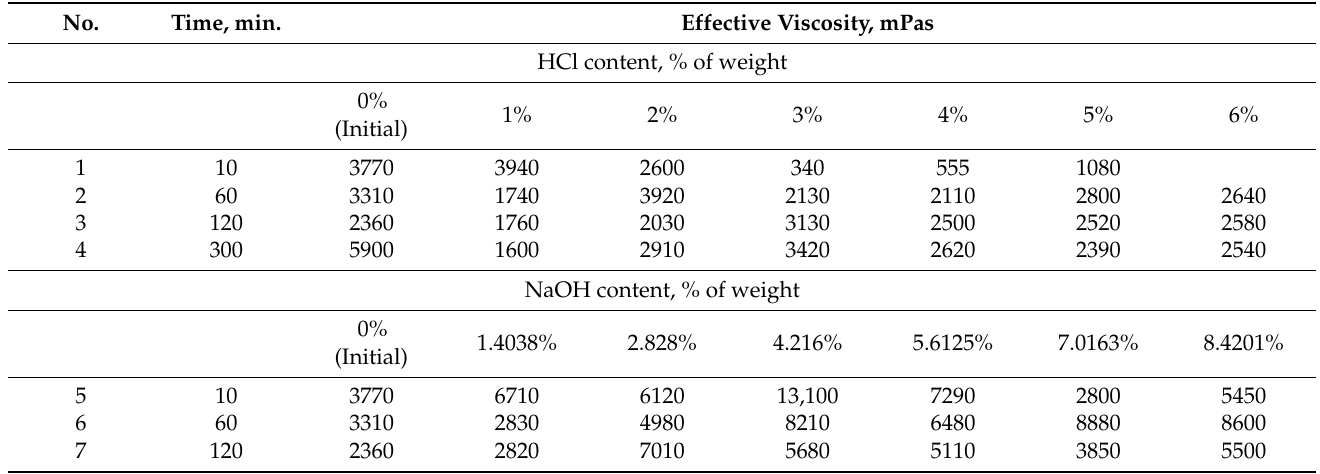
Table 4. The effective viscosity of the initial and proposed compositions with different contents of the gel-time modifier: HCl and NaOH (12% HCl solution).